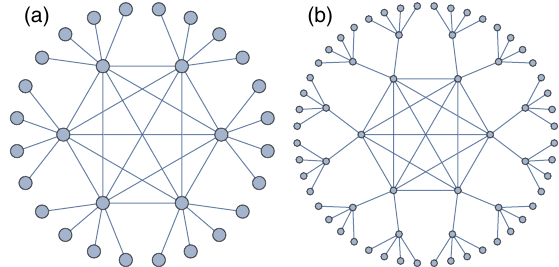
FIG. 5. Encoded RGS with (a) depth-one and (b) depth-two tree structures. Both of these can be generated by pumping a single emitter, which is coupled to an ancilla qubit via CZ gates.